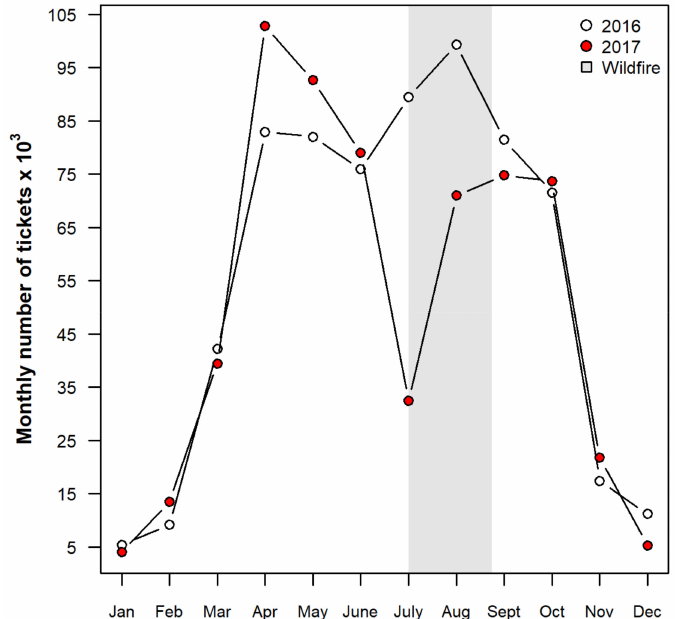
Figure 5. Trends in the monthly number of entry tickets to the “Gran Cono” tour of the Vesuvius volcano in 2016 (white circles) and 2017 (red circles). In 2017, the sharp decrease of visitors in July, and the gradual increase in August–September, are related to limitations in public access owing to wildfire occurrence and post-fire logging safety operations along the main access routes,